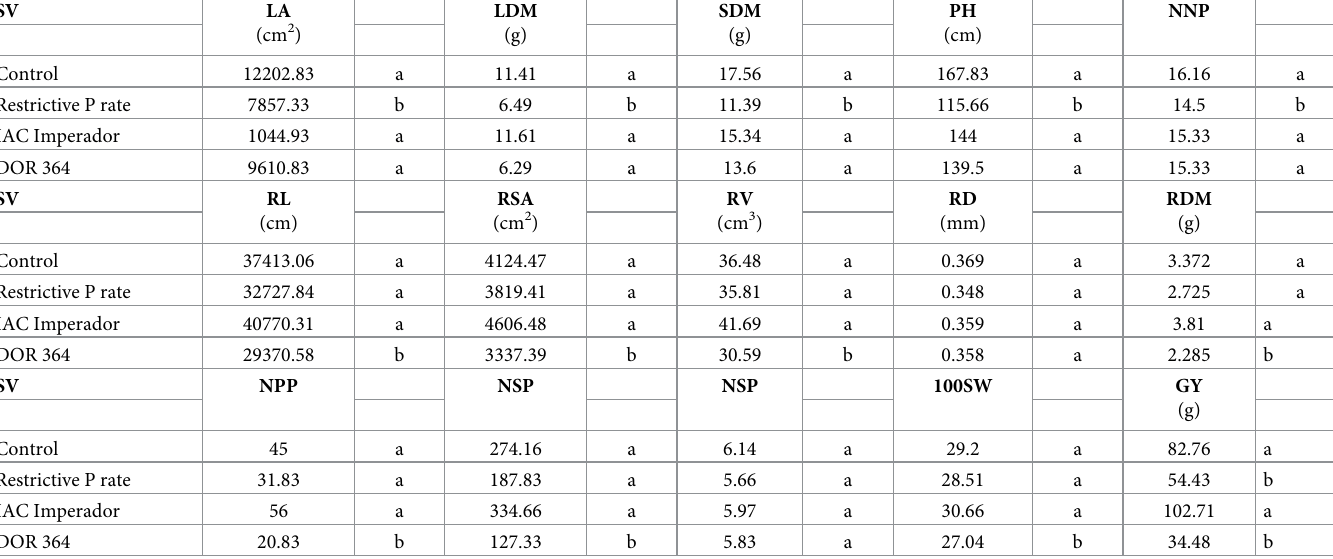
Table 2. Mean performance of the IAC Imperador and DOR 364 common bean genotypes grown hydroponically under a control and restrictive phosphorus condi- tion in regard to shoot, root, yield component, and yield traits. Scott-Knott test < 0.05. SV